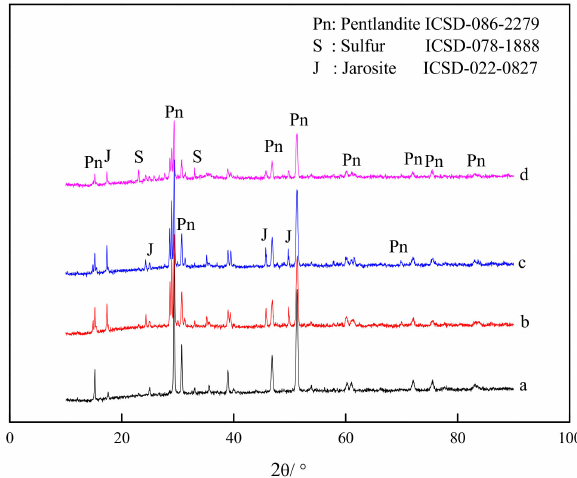
Figure 13. XRD pattern of filtered samples ( a ) pH = 2.00, leached for 8 days; ( b ) pH = 2.00, leached for